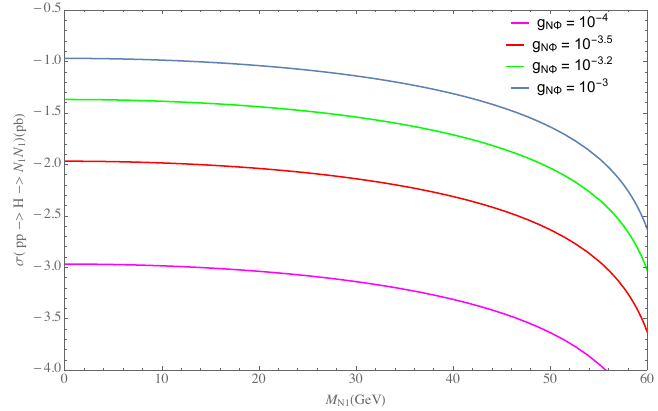
Figure 5 . Cross section pp a few values of g N (cid:8)